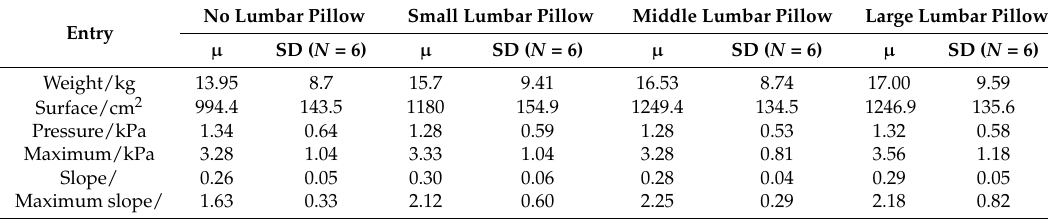
Table 1. The pressure distribution on the backrest surface [7]. SD: Surface Distribution.